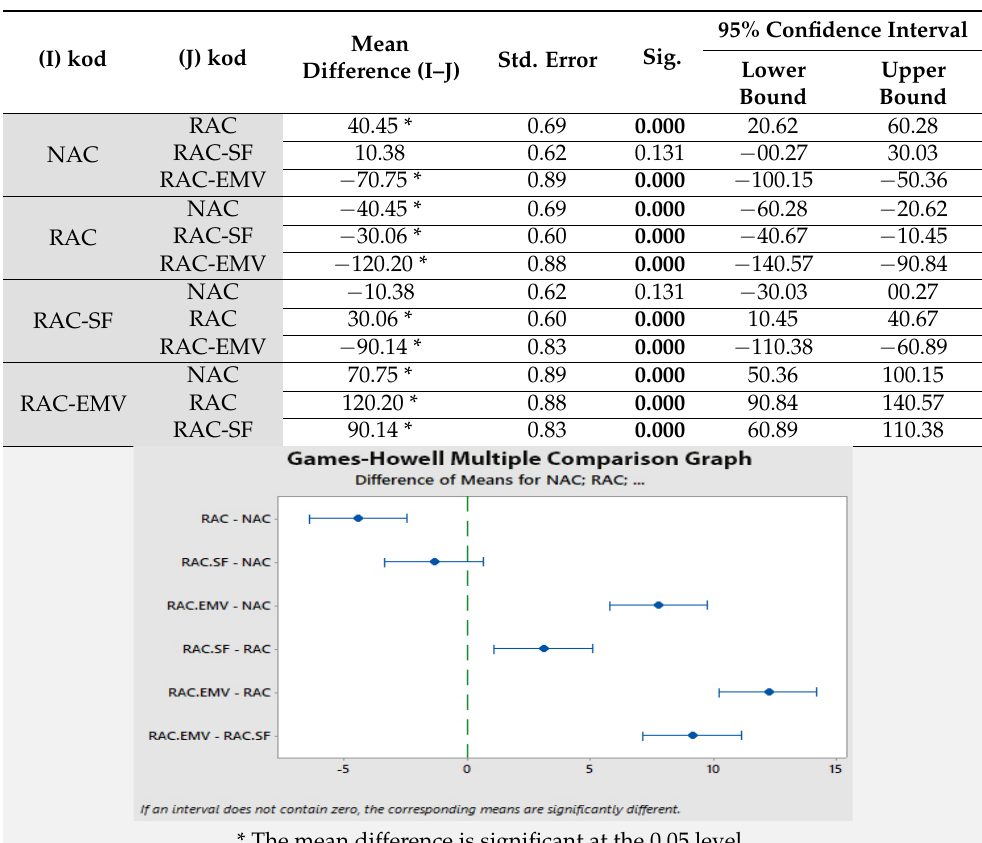
Table 10. Games-Howell Multiple Comparison test results and test graph.